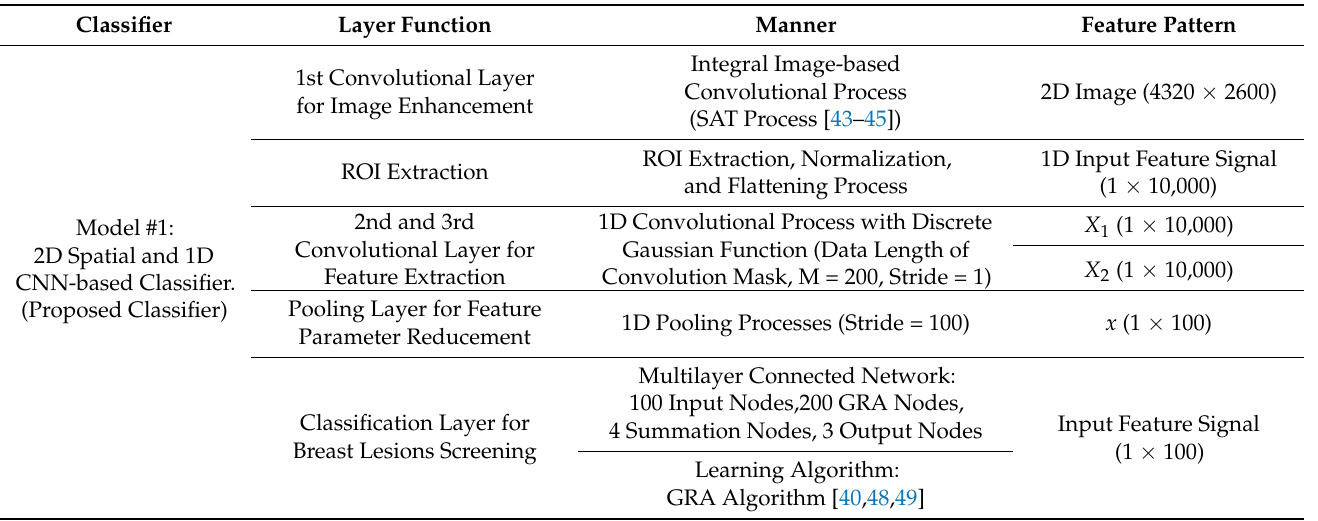
Table 2. Summary of models (Layer Functions, Manners, and Feature Patterns) for the proposed classifier and traditional CNN-based